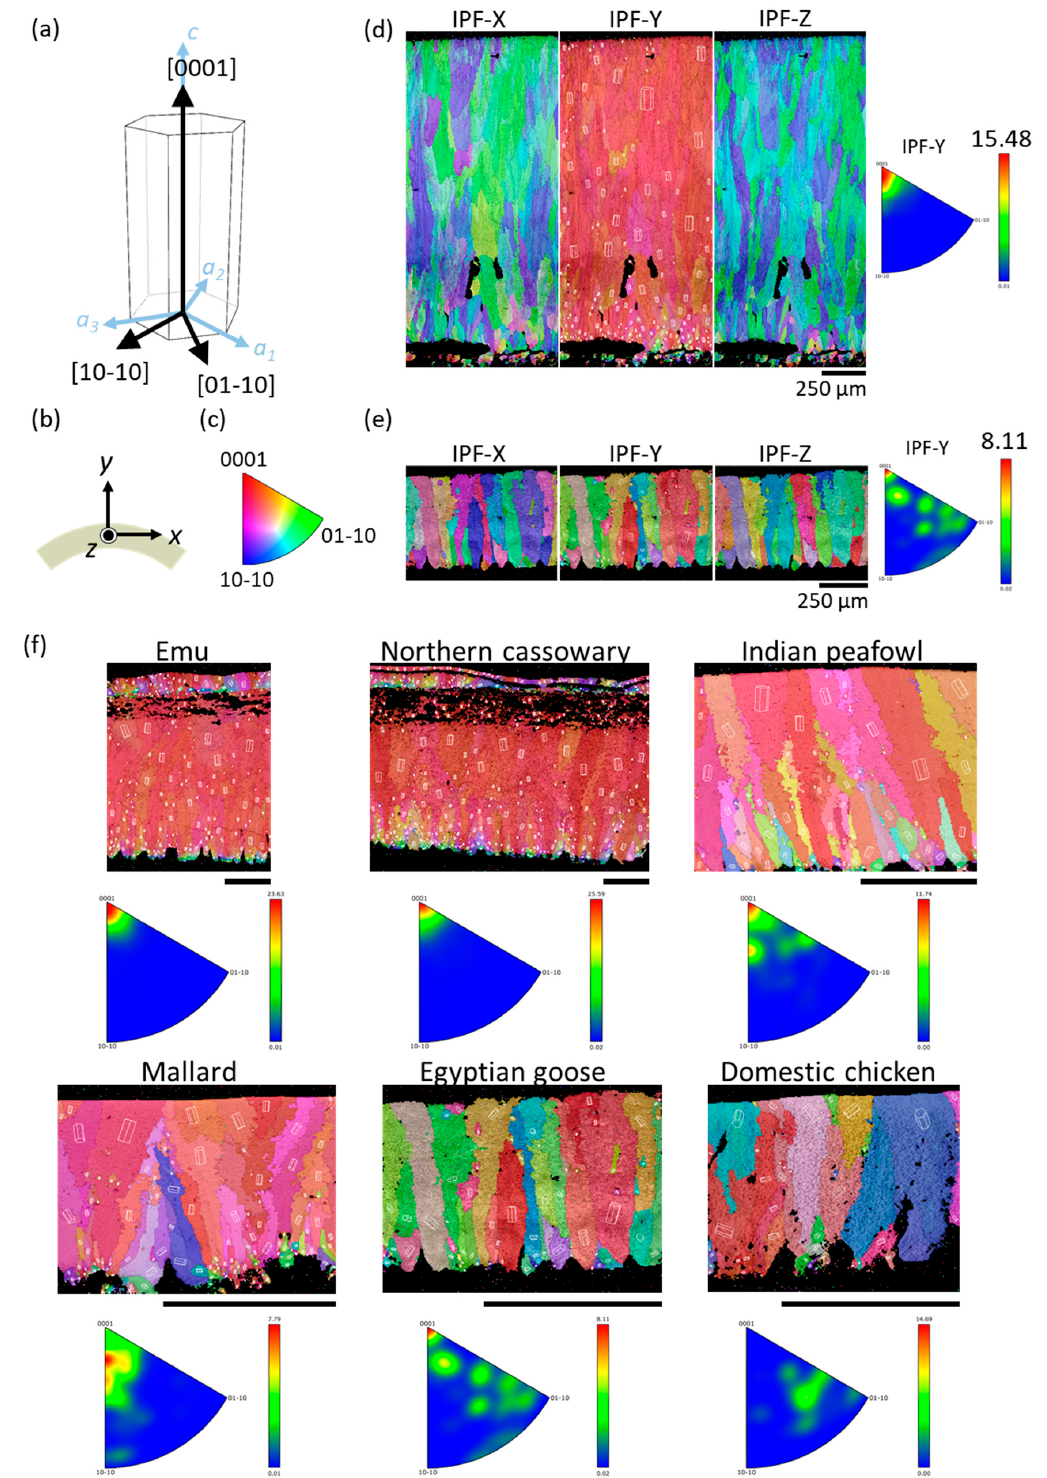
Figure 4. ( a ) Schematic diagram of calcite unit cell orientation with the Miller–Bravais indices. ( b ) The scanning direction of EBSD on a polished eggshell cross-section. The eggshell specimens under the Cartesian coordinate with y -axis pointing to the normal direction of the eggshell. The x- and z -axes are parallel to the eggshell surface. ( c ) An IPF map key shows the relationship between the color and the orientation. ( d , e ) The IPF maps of avian eggshell obtained by EBSD. ( d ) Ostrich; ( e ) gray junglefowl. ( f ) The IPF- Y maps and corresponding inverse pole figures of avian eggshell obtained by EBSD. The scale bars are 250 μ m.